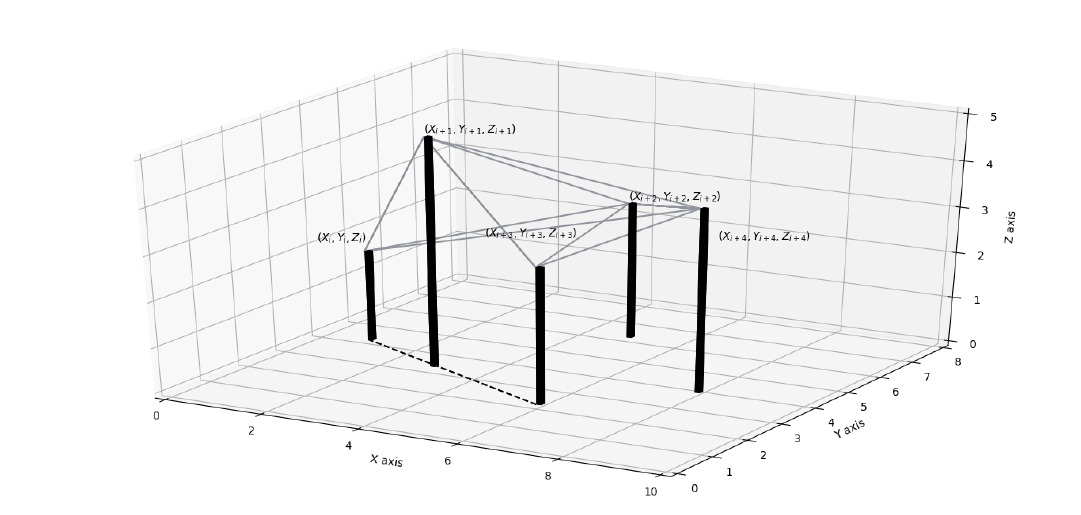
Figure 2. A part of the 3D Visibility Graph constructed out of a set of { ( x , y , z ) }